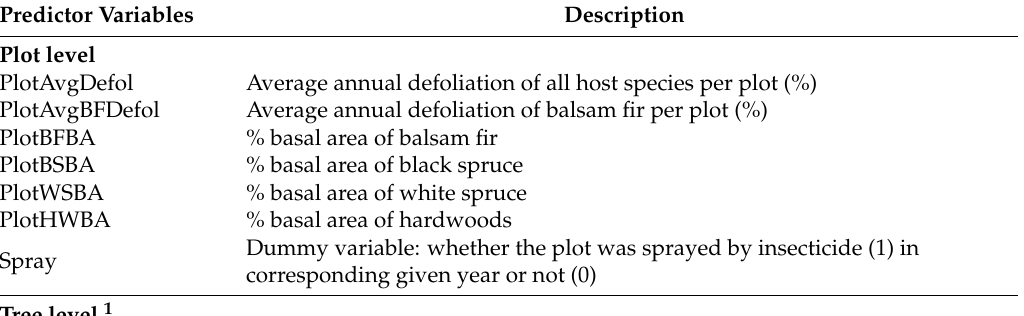
Table 4. Abbreviations and description of predictor variables at both plot and tree levels included in Gradient Boosting Machine analysis to determine their relative importance in predicting annual defoliation of a subject balsam fir